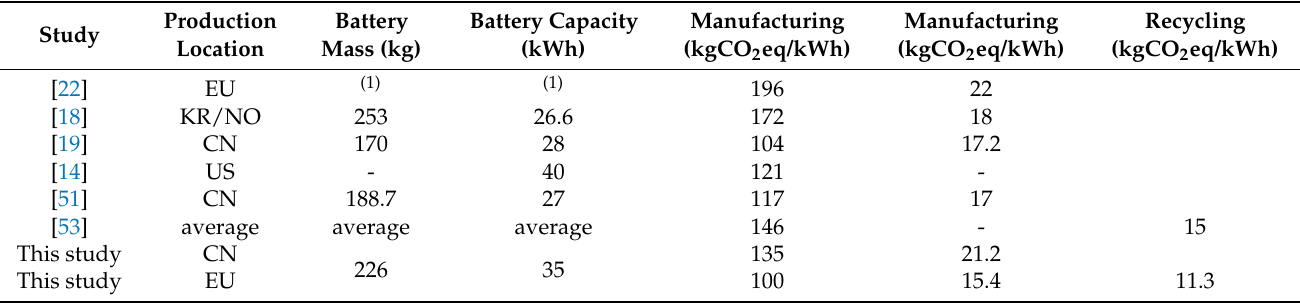
Table 6. The impacts of GWP on NMC batteries in